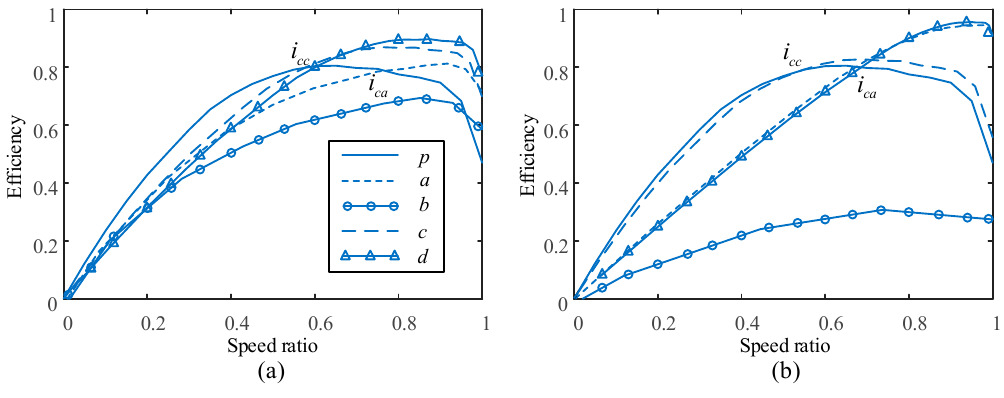
Figure 9. Efficiency of each solution. (a) τ = 4/3; (b) τ = 5.